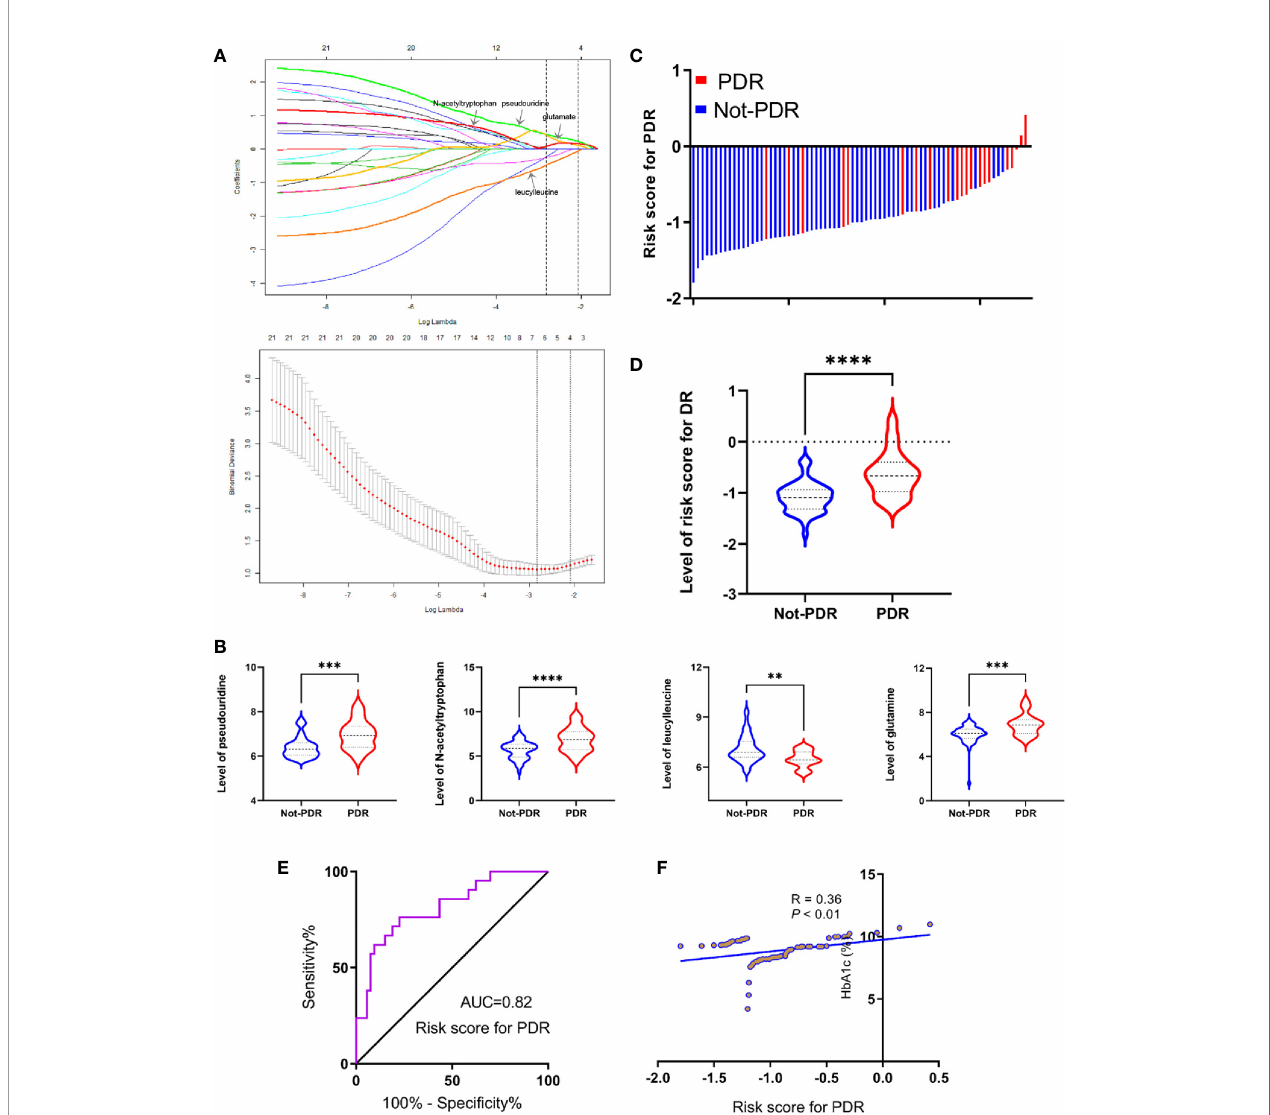
FIGURE 5 | Development of risk score for PDR using the least absolute shrinkage and selection operator regularization (LASSO-LR) model. (A) Dotted vertical lines were drawn at the optimal values with Lambda (log), by using the minimum criteria and the 1 standard error of the minimum criteria (the 1-SE criteria). (B) Statistical analysis of pseudouridine, glutamate, leucylleucine and N-acetyltryptophan between PDR and not-PDR group (**p < 0.01; ***p < 0.001; ****p < 0.0001). (C) Distribution of the risk score in the group. (D) Statistical analysis for distribution of risk score between PDR and not-PDR group (****p < 0.0001). (E) ROC curves were created to evaluate the power of risk score. (F) A linear correlation analysis between risk score and HbA1c